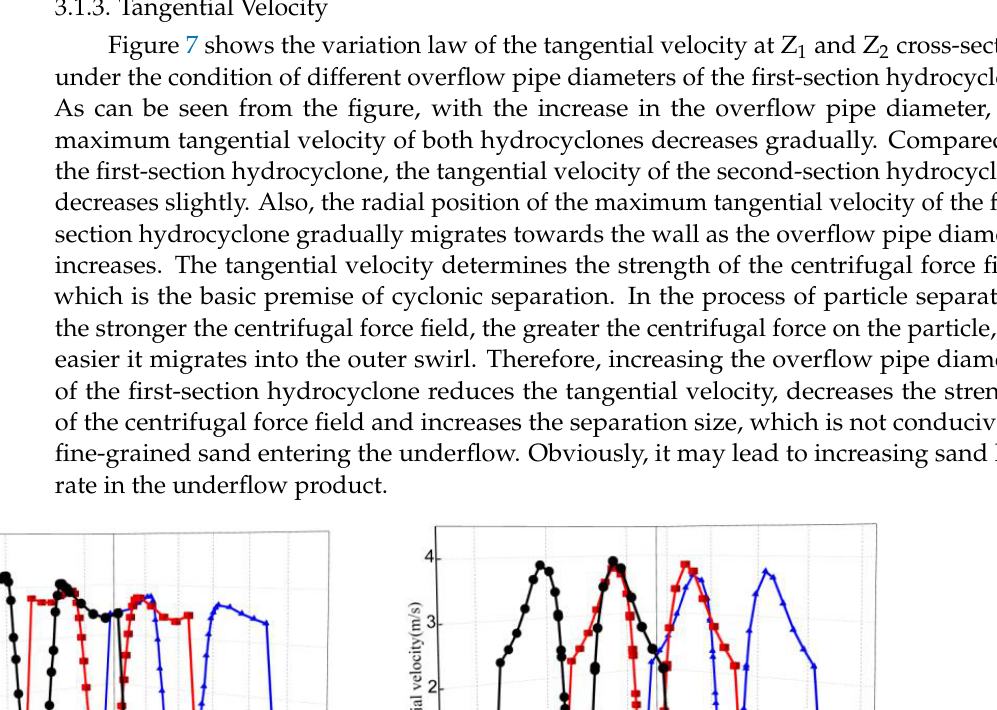
Figure 6. Effect of the first-section overflow pipe diameter on axial velocity ( a ) Cross-section of Z 1 ; ( b ) Cross-section of Z 2 .